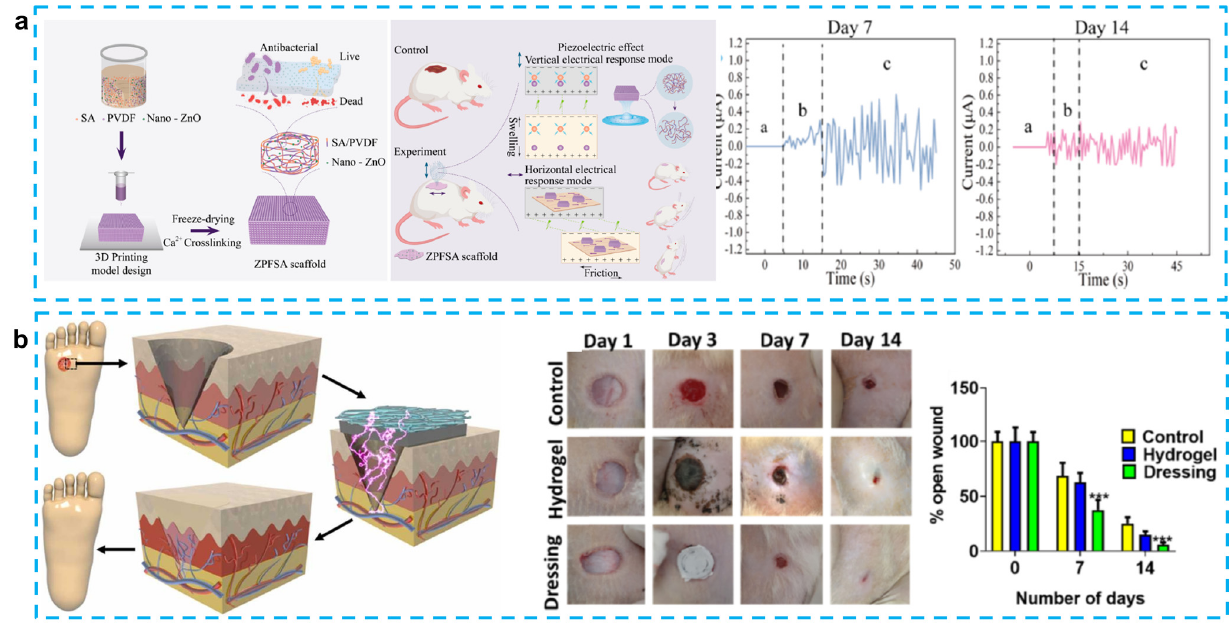
Figure 6. ( a ) 3D-printed piezoelectric wound dressing with dual piezoelectric response models for scar-prevention wound healing. (Reprinted with permission from Ref. [89], Copyright 2022, American Chemical Society.) ( b ) Electrical stimulation induced by a piezo-driven triboelectric nanogenerator and electroactive hydrogel composite accelerating wound repair. (Reprinted with permission from Ref. [90], Copyright 2022, Elsevier Ltd.)